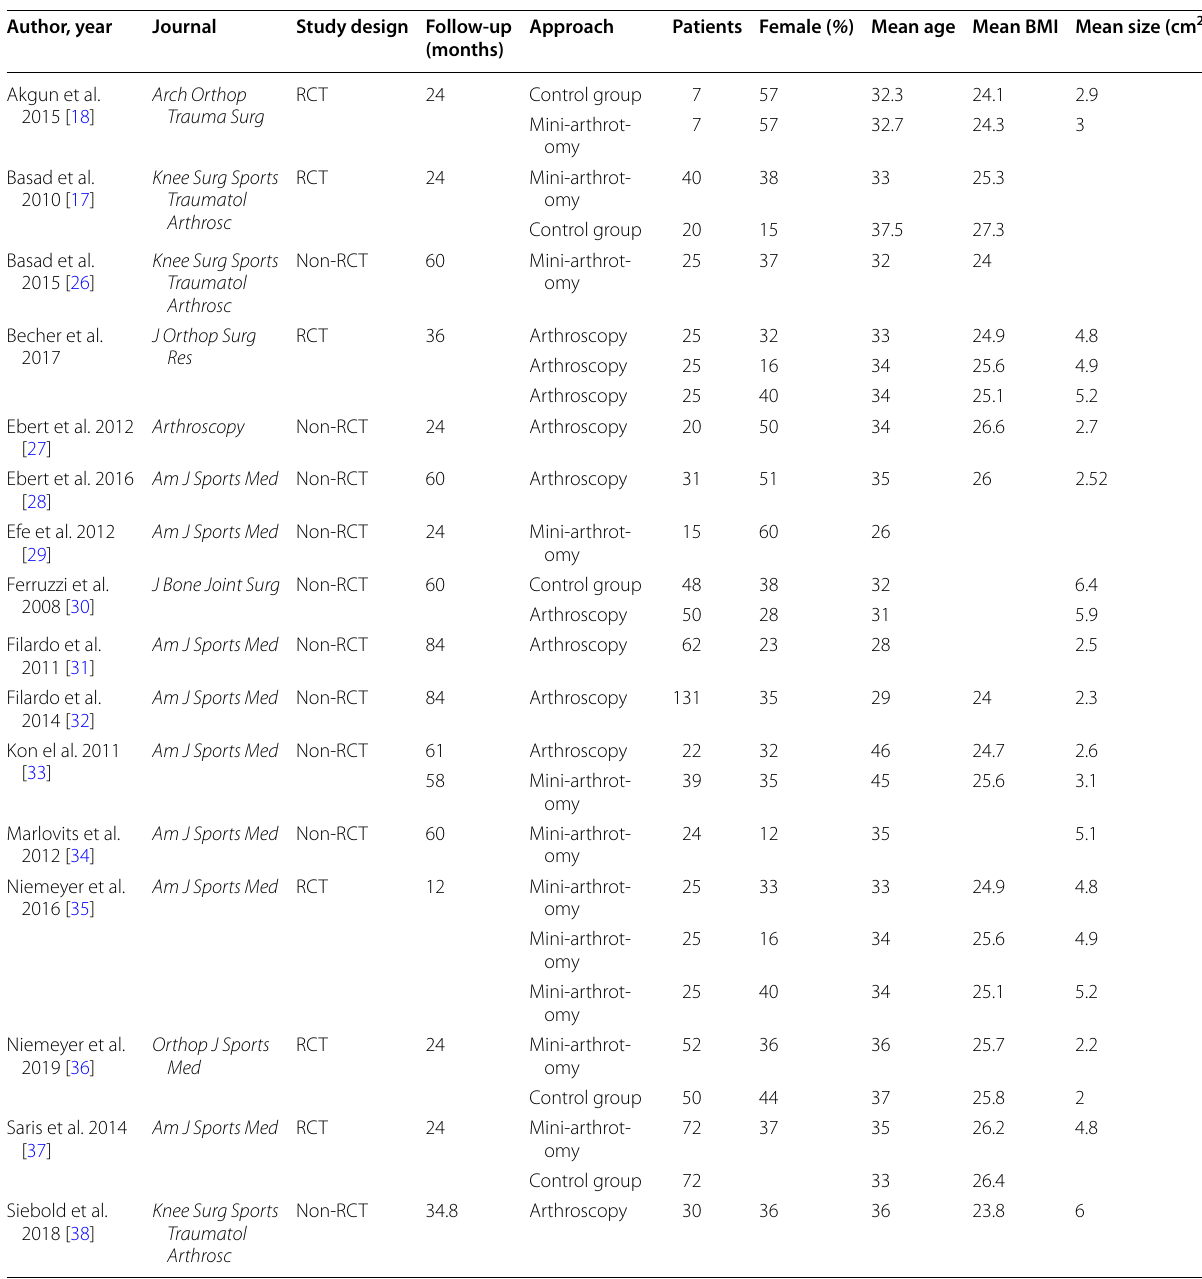
Table 2 Generalities and patient baseline of the included studies Author,